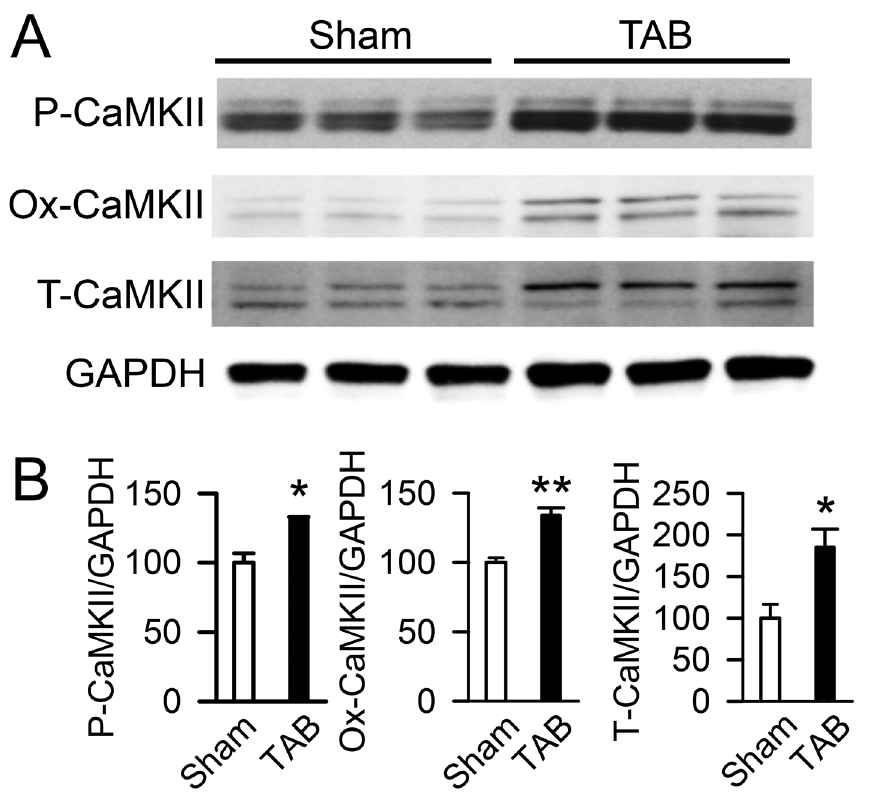
Fig 2. CaMKII is activated in ventricles of hearts following transverse aortic banding. A) Representative western blots of phosphorylated CaMKII (P-CaMKII), oxidized CaMKII (Ox-CaMKII), total CaMKII (T-CaMKII) and GAPDH in ventricles of sham and TAB mice as labelled by whole-heart biotinylation. B) Summary of P-CaMKII, Ox-CaMKII and T-CaMKII quantification from western blots in ventricles of sham and TAB mice ( * p < 0.05, ** p < .01 vs .